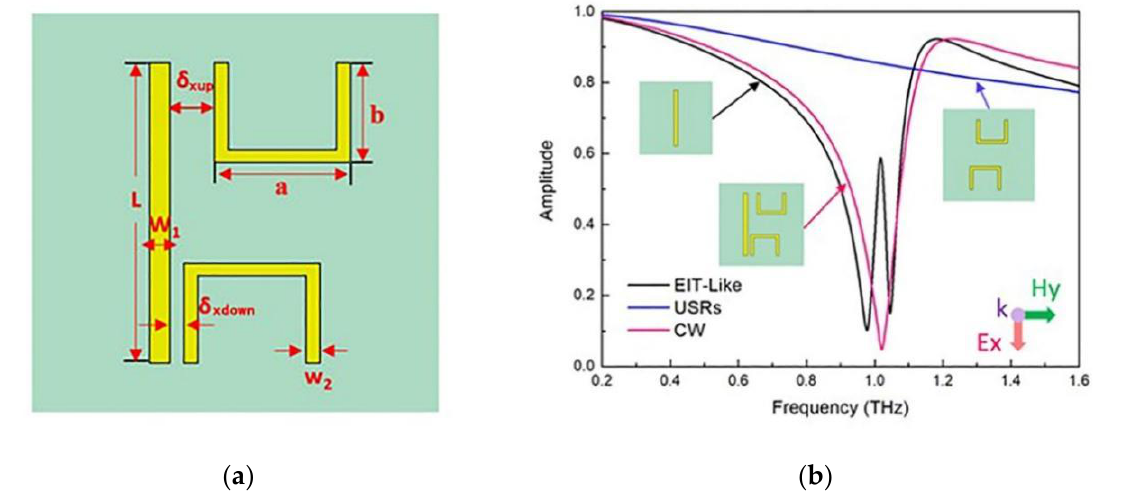
Figure 2. The transmission properties of metamaterial structure based on asymmetric structures. ( a ) Asymmetric structure distribution of upper and lower USRs with different distances from the CW; ( b ) The transmission spectra of the asymmetric EIT structure shows a transparent window similar as the symmetric structure at 1.02